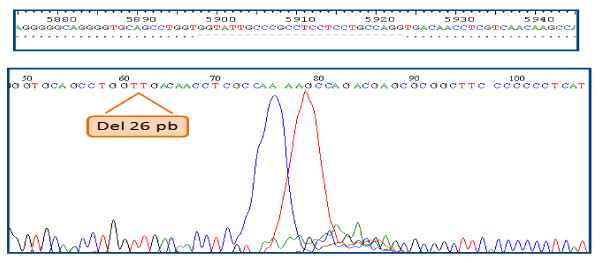
RFXANK mutation.